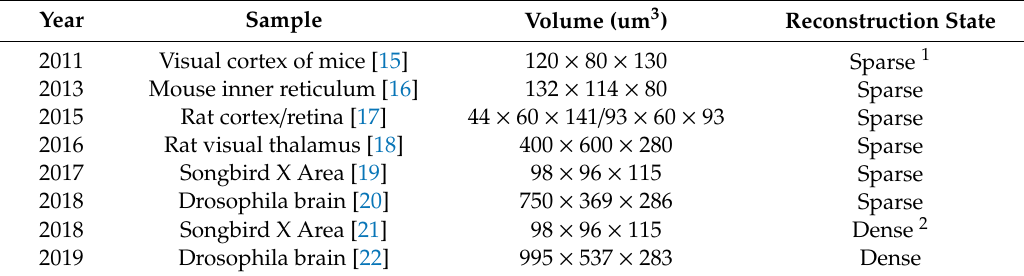
Table 1. Reconstruction results over the